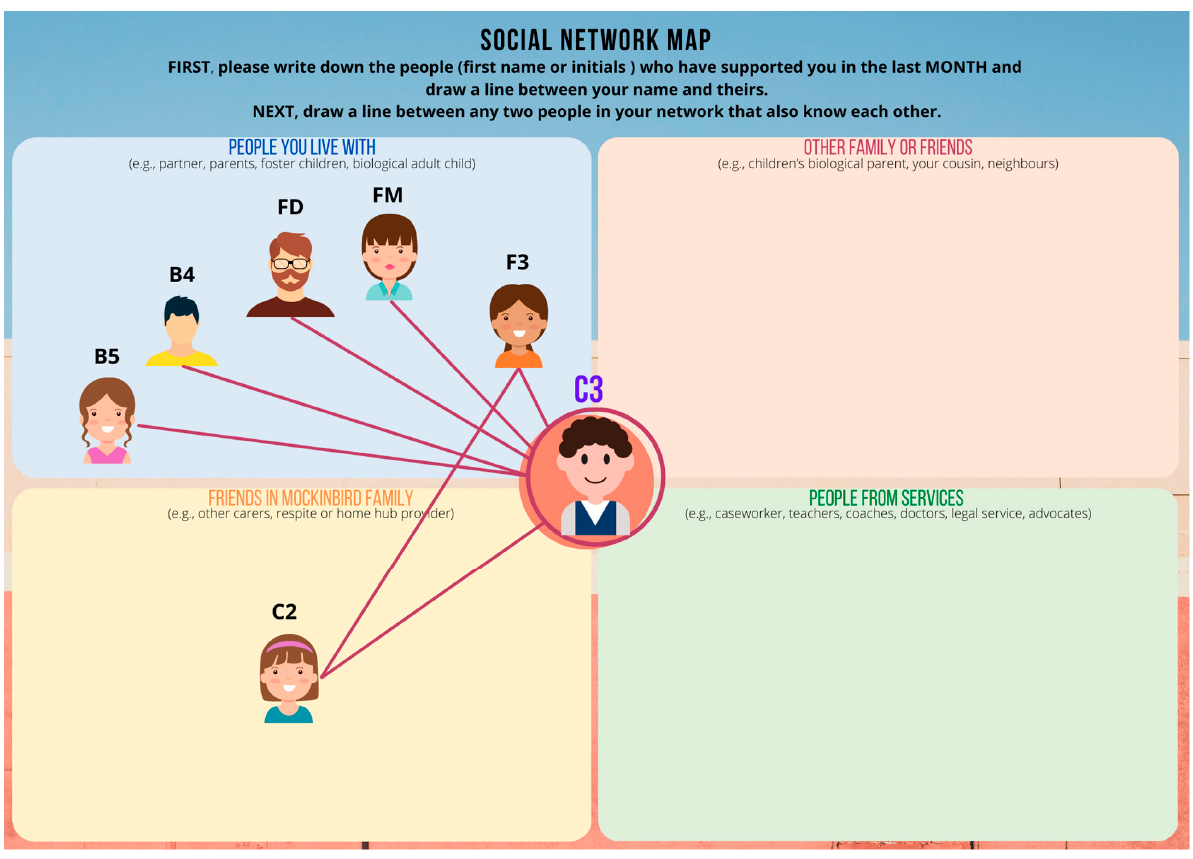
Figure 1. Example of a completed social network map.